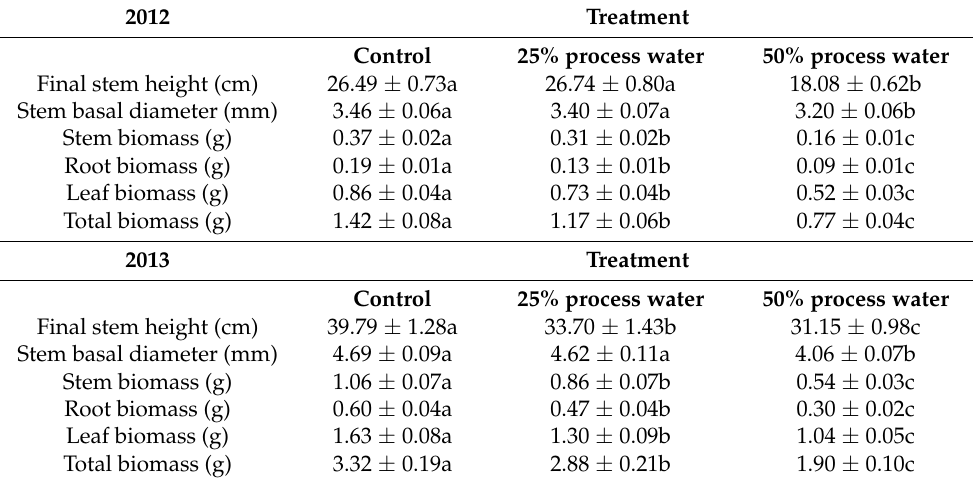
Table 1. Mean values ( ± SE) for growth and biomass measurements of balsam poplar in 2012 (top) and 2013 (bottom) for all three treatments. Significant differences between treatment means within each row are indicated by different letters based on results of analysis of variance followed by post-hoc Student–Newman–Keuls (SNK)